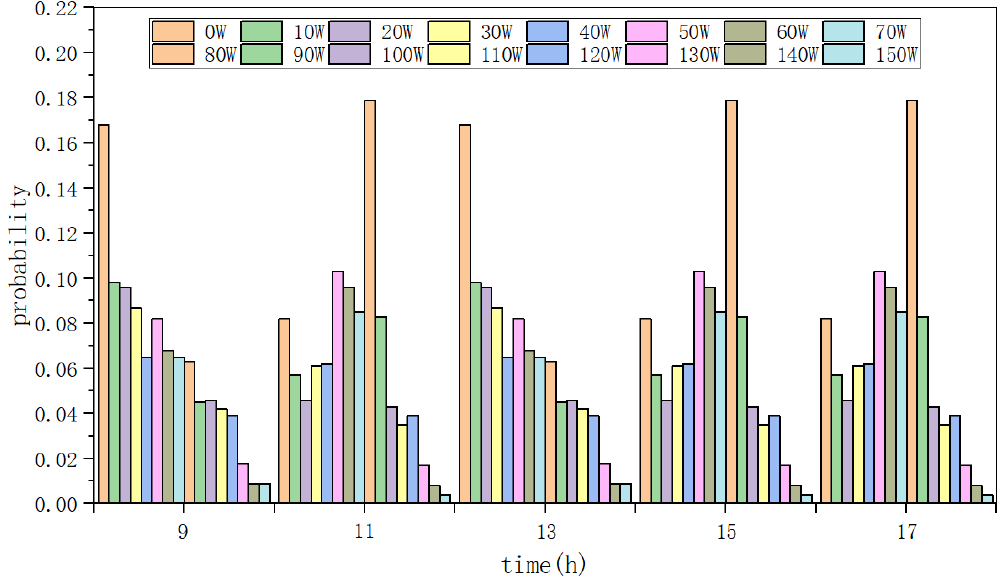
Figure 8. Probability of different power usage of computer at different time. According to the survey of the use of appliances by China National Bureau of Statis- tics, the probability of using printers, projectors, and scanners at different times can be determined as shown in Figure 9: